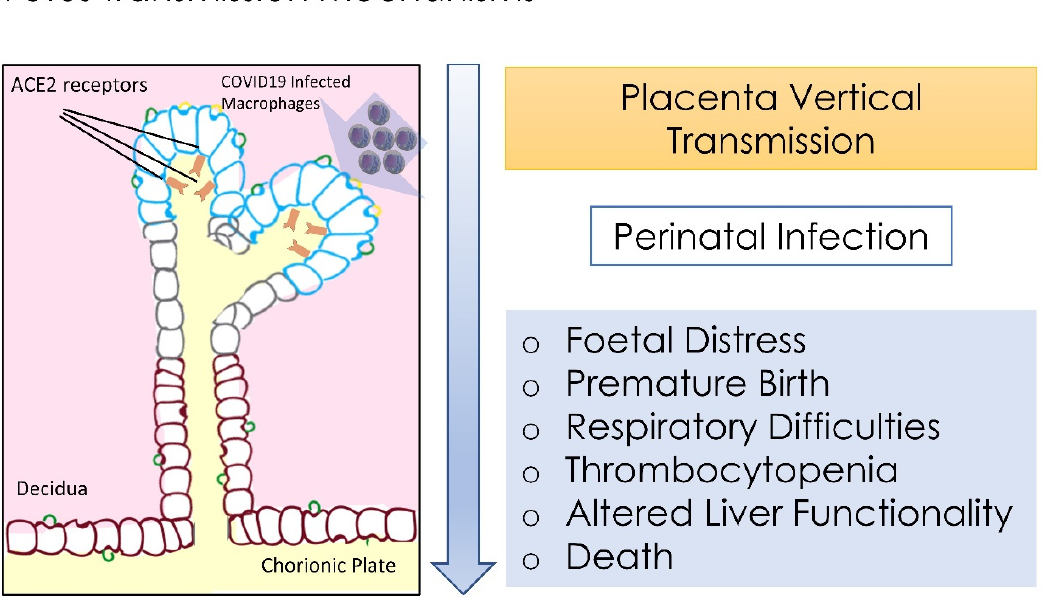
Figure 1. Foetus transmission of SARS-CoV-2 and principal systemic distresses.